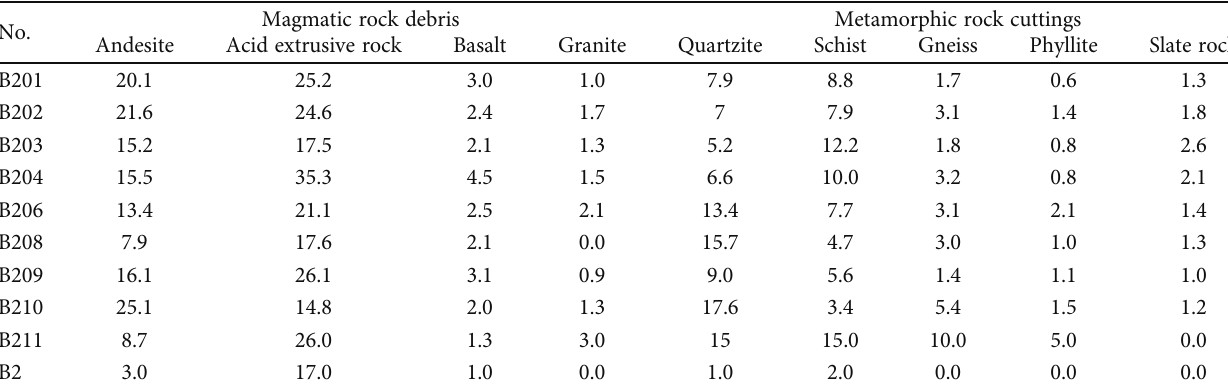
Figure 10: Triangular diagram of the sandstone classi fi cation of the Yingcheng and Shahezi formations in the study area. Table 3: Statistics of cuttings types and content in the study